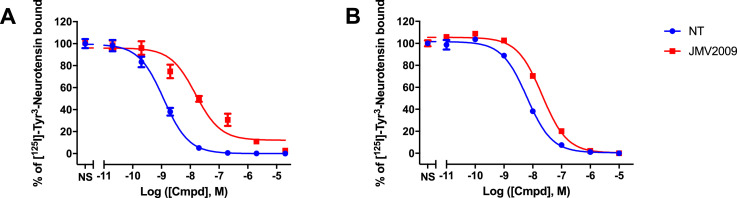
Concentration-displacement curves of NT and JMV2009. Displacement of [125I]-Tyr3-Neurotensin by NT and JMV2009 on cell membranes expressing hNTS1 (A) or hNTS2 (B).